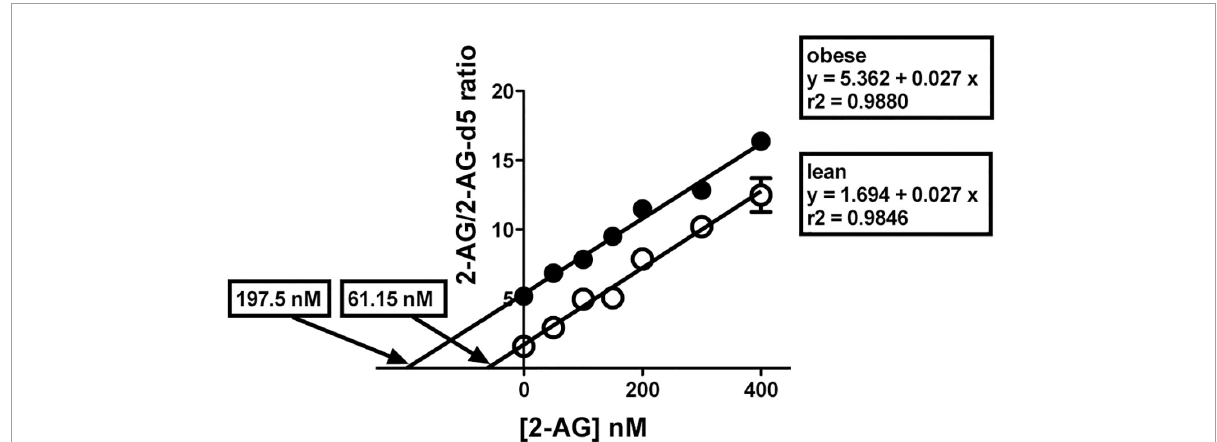
FIGURE11 2-AG levels in brain cortical regions. Representative illustration of the method of isotopic dilution combined with standard addition techniques to determine endogenous 2-AG levels in brain cortex. Three separate experiments, each with 21 subsamples (aliquots of the brain cortical homogenate), were performed in triplicate. Prior to addition of ethylacetate/hexane for extraction, 2-AG-d 5 and 1-AG-d 5 (both, 100 nM), and 2-AG standard at varying amounts (0, 50, 100, 150, 200, 300, and 400 nM) were added to the subsamples. Results for the normalized signal strength for 2-AG/2-AG-d 5 from lean ( ◦ ) and obese Zucker prefrontal cortex ( • ) are presented with individual best fit lines. The lines are essentially parallel but have different intercepts. Each data point is the mean ± SD of a triplicate in one experimental assay. Three independent assays were performed to obtain data shown in Table 3